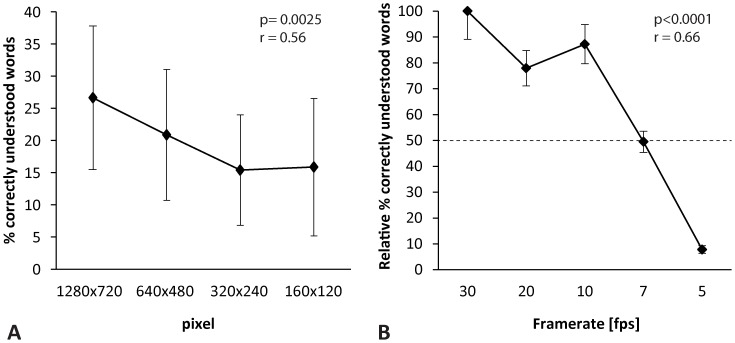
Speech reading performance (mean +/−1 SD) by n = 14 deaf individuals for 4 different spatial resolutions (A) and 5 different frame rates (B).In B, the maximum achieved speech perception at 30 fps is set to 100% (relative data). Mean speech perception scores remained above 80% until the frame rate of 10 images per second. Frame rates <10 fps were associated with a substantial reduction of the speech reading performance and frame rates at 7 fps led to a 50% reduction of the initial performance at optimal video quality. Speech reading at 5 fps was almost impossible.